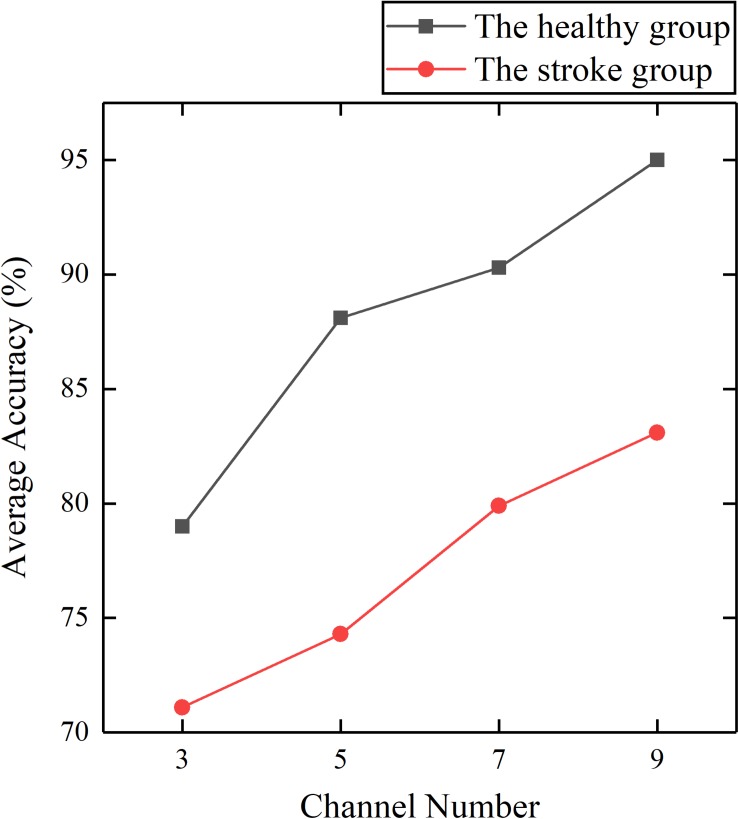
Average accuracy of the healthy and stroke group models established by different channel numbers.